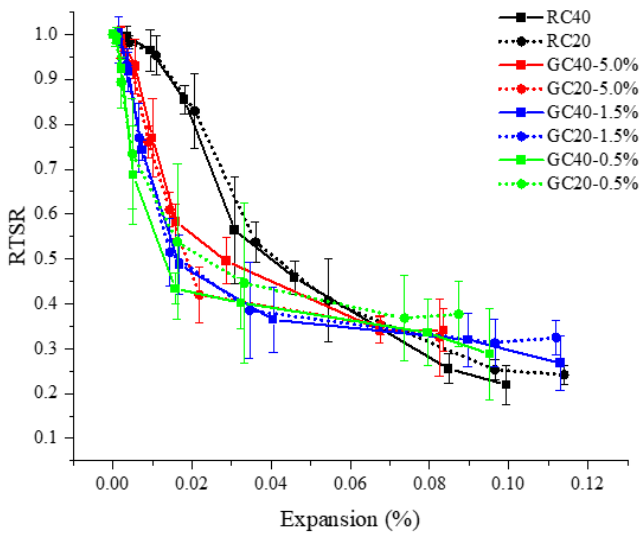
Figure 11. Declining trend of RTSR with AAR expansion of the specimens.